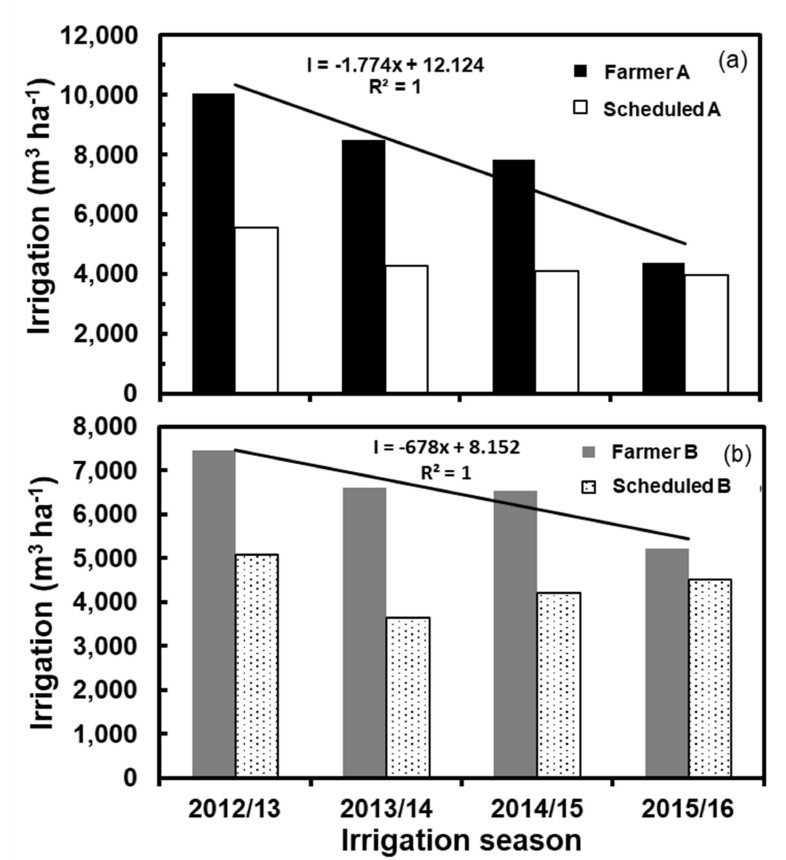
Figure 7. Irrigation applied by Farmer A ( a ), Farmer B ( b ), and irrigation scheduled by IFAPA in both